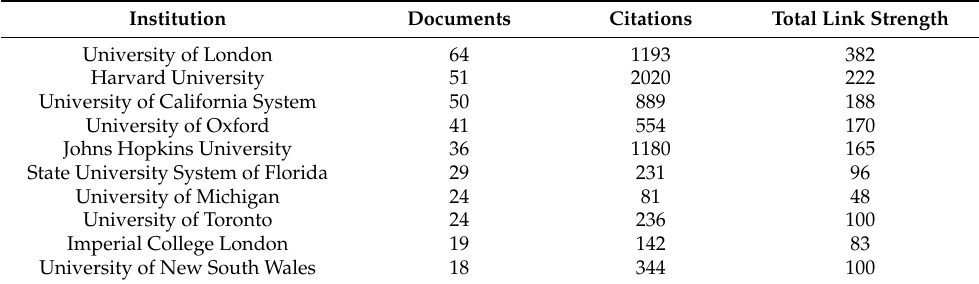
Table 5. Top 10 productive institutions.